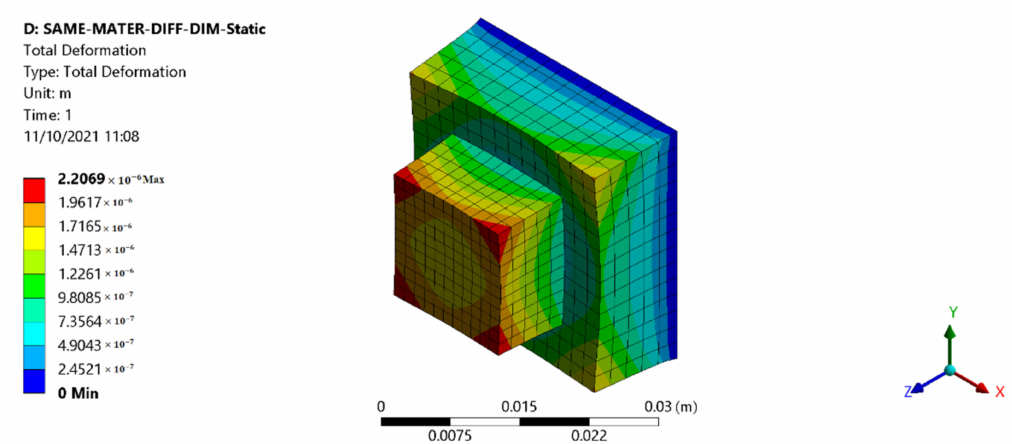
Figure 10. The result of the static analysis of a pair of two PIN24%-PMN-PT plates of different dimensions using Method